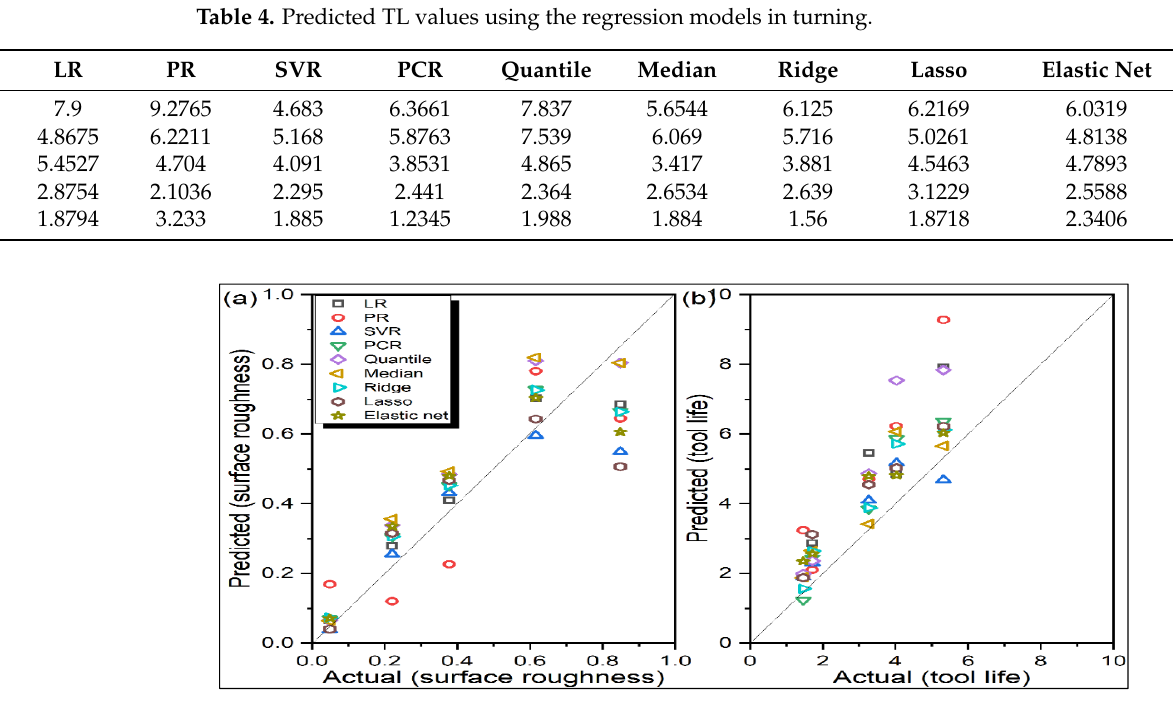
Figure 1. Actual versus predicted responses for turning ( a ) Ra ( b ) TL.